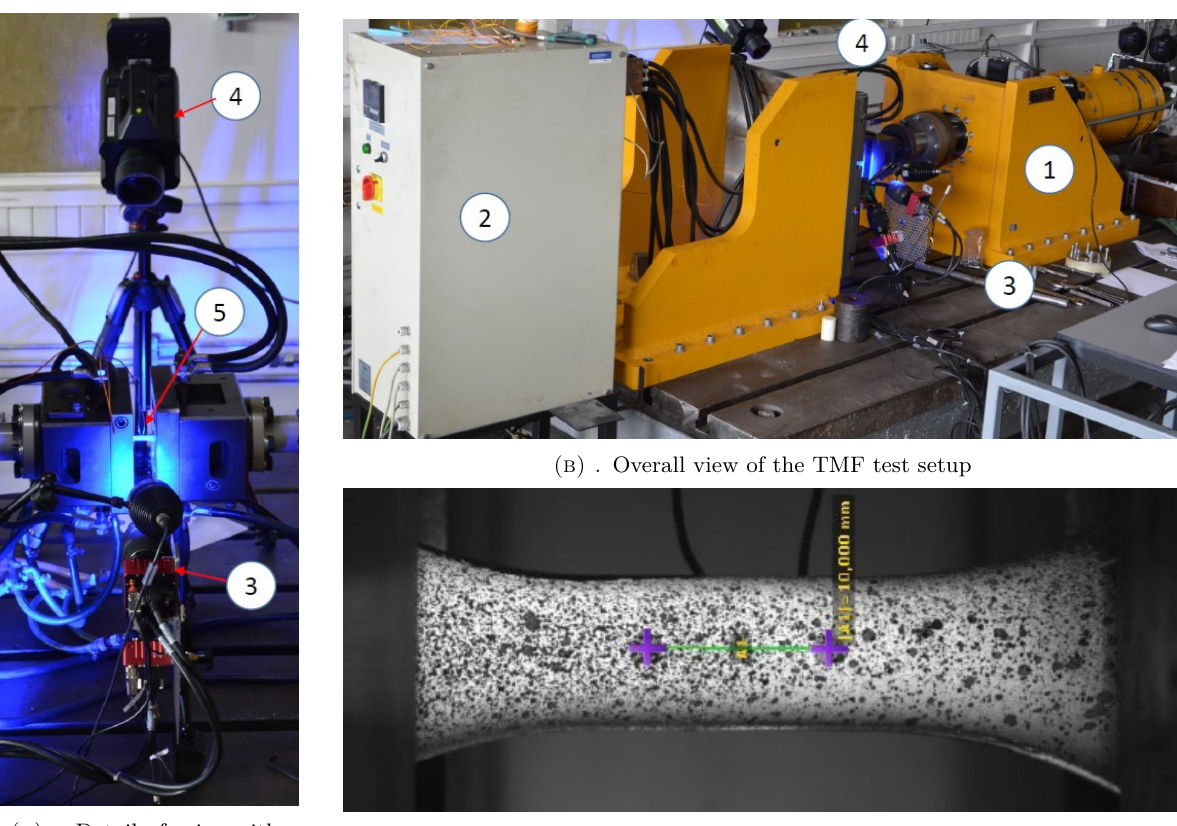
Figure 4. TMF test setup and specimen. 1 - servohydraulic axial-torsional test machine, 2 - resistance heating, 3 - camera of the DIC system, 4 - infrared camera, 5 - test specimen.